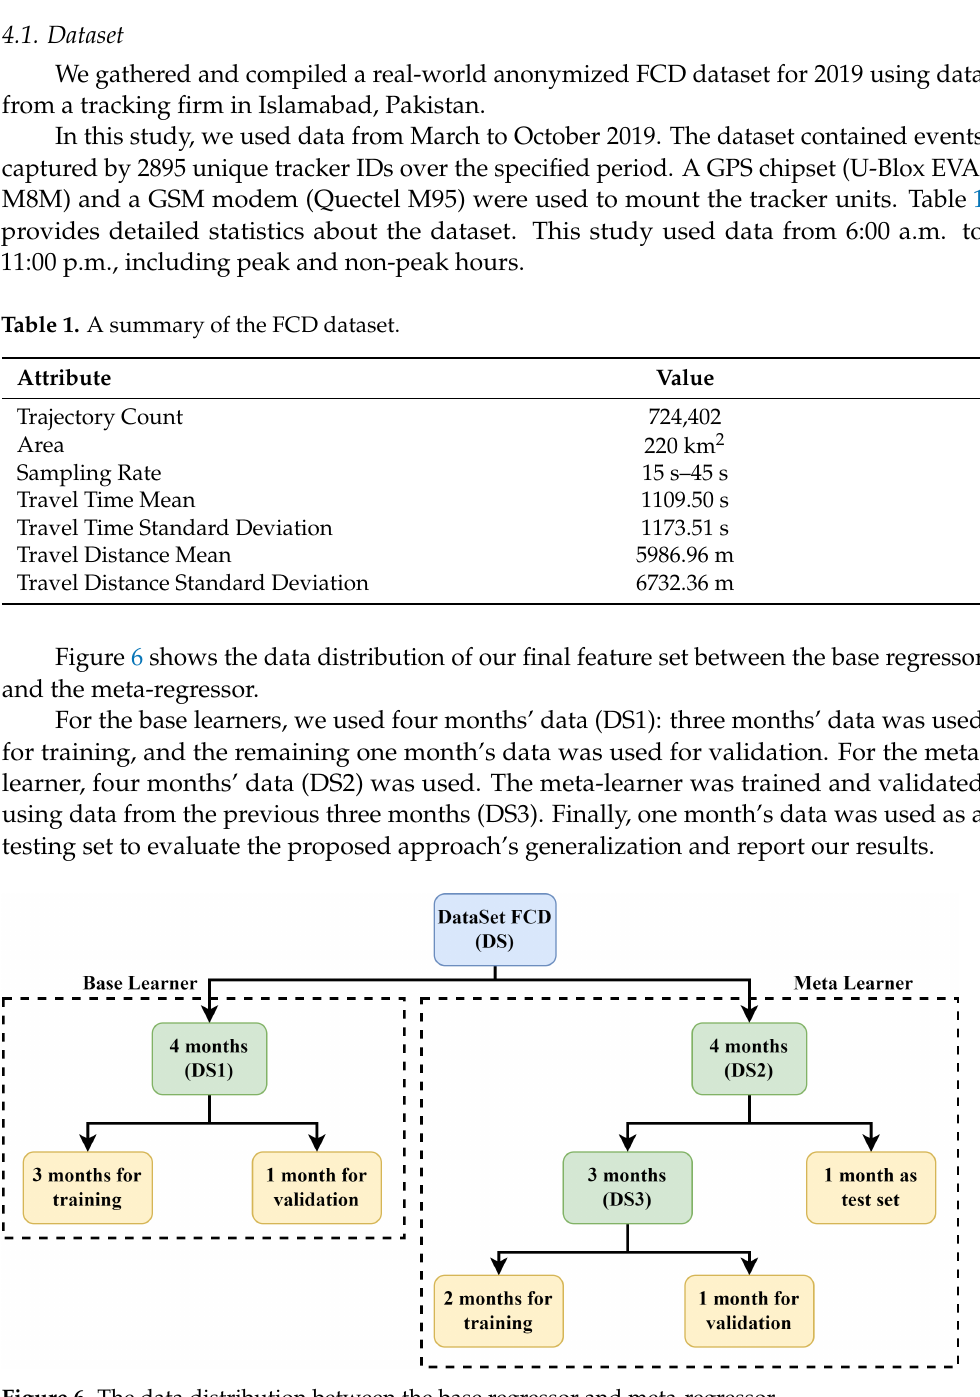
Figure 6. The data distribution between the base regressor and